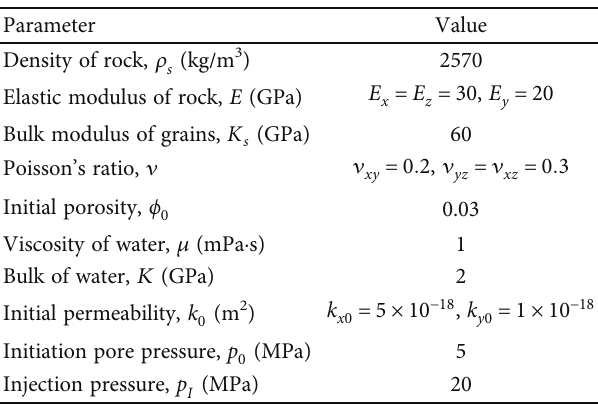
Figure 3: Changes of permeation depth with permeability during water and gas